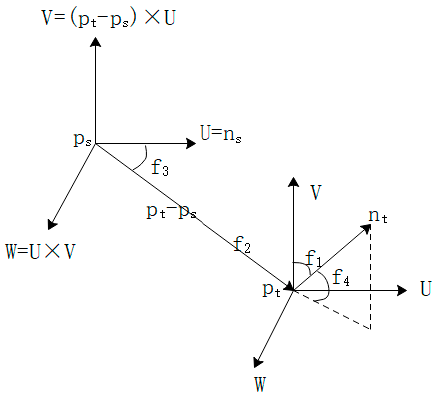
Figure 3. Local coordinate system between point pairs.